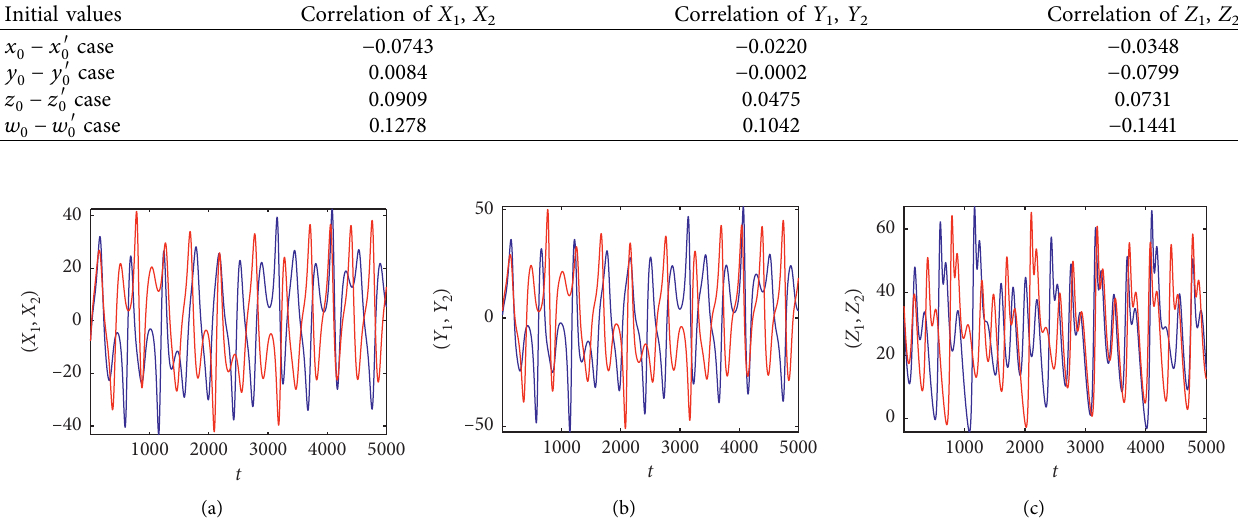
,z , w ] : (a) ( X ′ , y 0 0 0 0